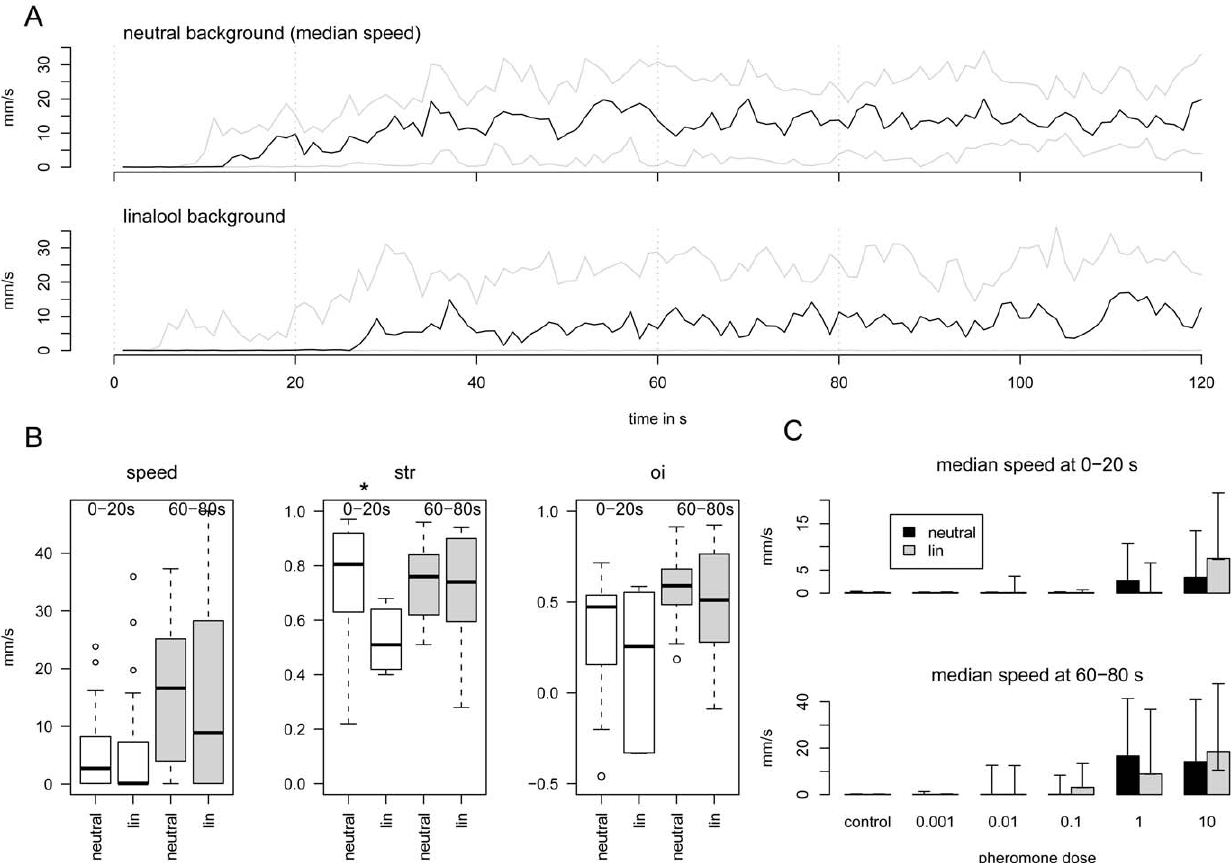
Figure 3. Analysis of the PWR in neutral or linalool background. A) Time plot of the median speed during the 2-min test in neutral or Lin backgrounds (median in black; first and third quartiles in grey, N =20 for each group). B) Box plots of the median speed, straightness (str) and orientation index (oi) calculated within two 20-s time windows (delimited by vertical grey dashed lines in A) at the beginning (white bars) and the middle of the response (grey bars). In box plots, the bold line presents the median value, the limits of the boxes (hinges) are the first and third quartiles, the whiskers present the extremes and the dots the outliers. The values were compared with a Mann-Whitney test. Significant differences at 5% are indicated by *. C) Phero-dose response curves (median speed), measured within two time windows at the beginning and the middle of the recording for neutral (black bars) or Lin backgrounds (grey bars) ( N =20 for each group).